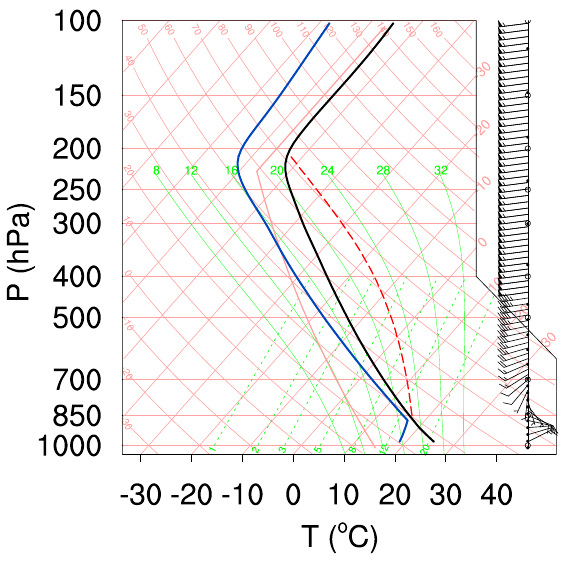
Fig. 1. Skew-T log-P diagram for the simulations with baseline ini- tial conditions. Temperature ( T , black) and dew point temperature ( T d , blue) are shown.